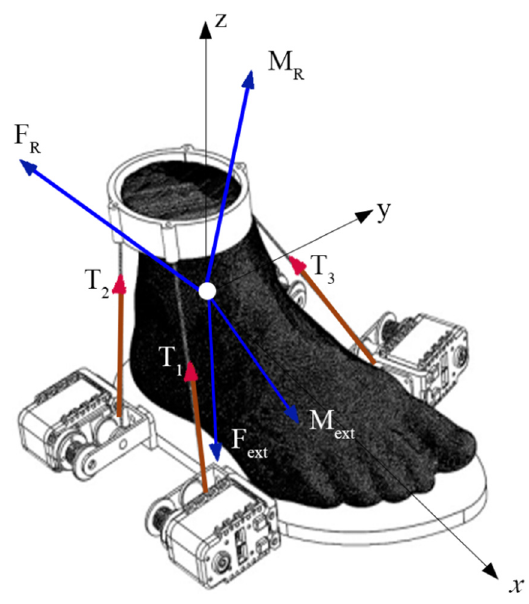
Figure 4. Static model of CABLEankle.